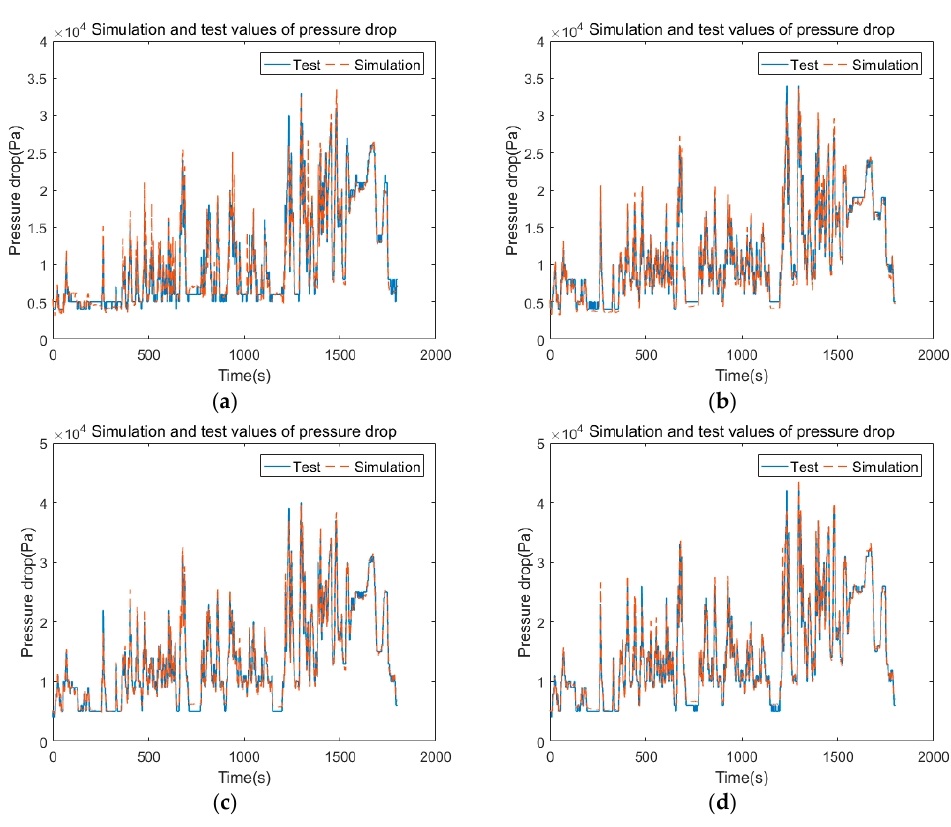
Figure 3. Comparison between simulation and test values of the pressure drop: ( a ) Pressure drop under the 1st cycle; ( b ) Pressure drop under the 4th cycle; ( c ) Pressure drop under the 15th cycle; ( d ) Pressure drop under the 20th cycle.